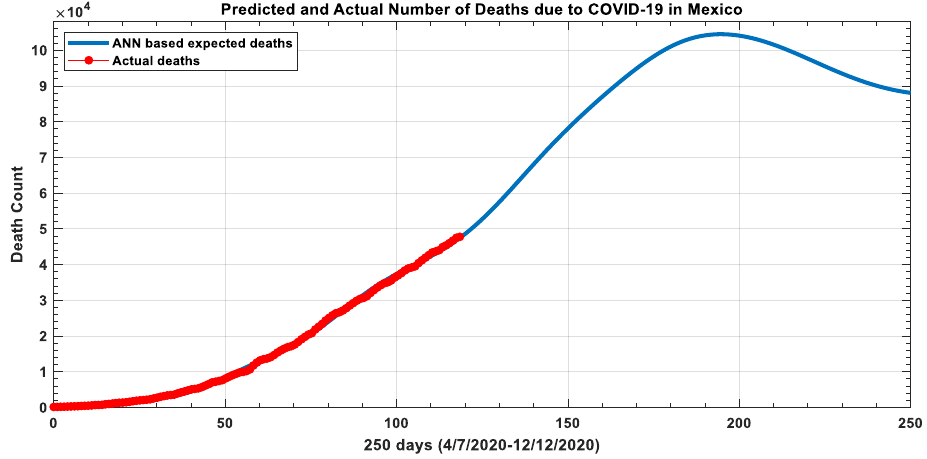
Figure 9. The training data and predicted data of COVID-19 recovered people in Mexico.